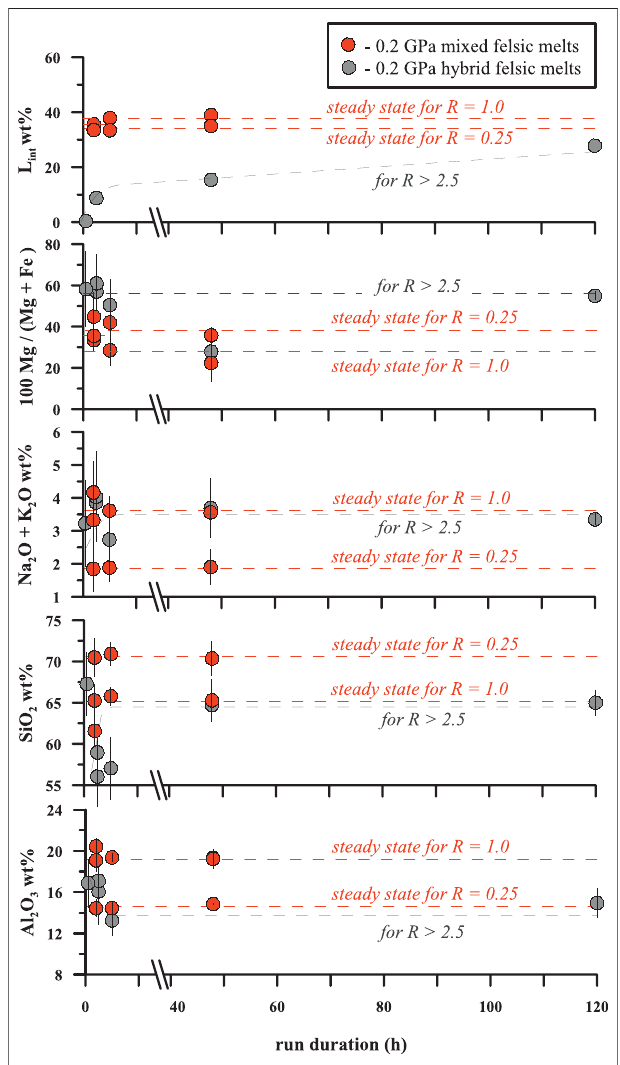
FIGURE 4 | Weight proportion of interstitial felsic melt (in wt%), magnesium index (100 Mg/(Mg + Fe), total alkalis, SiO 2 and Al 2 O 3 (in wt%) in the interstitial felsic melts of the time-series experiments vs. run duration (h). Theoxidecontentsarerecalculatedto100%onavolatile-freebasis.Ris the mass ratio of starting basaltic melt to serpentinite rock (basalt-to- serpentinite ratio). The dotted lines indicate compositional tendencies for the felsic melts of the mixed and hybrid runs. The mixed runs for given R values (0.25 and 1.0) are characterized by homogeneous interstitial felsic melts with constant Si, Al, and alkalis, while L int proportions are independent of run duration. We argue for near equilibrium (steady) state of the produced felsic melts in assemblages with high-Mg olivine based on the mixed time-series experiments. Constant concentrations are established very early (in less than 2 h) for R (cid:1) 0.25 and R (cid:1) 1.0 in the mixed runs, suggesting attainment of steady state or thermodynamic equilibrium of the run products. X axis scale breaks from 12 to